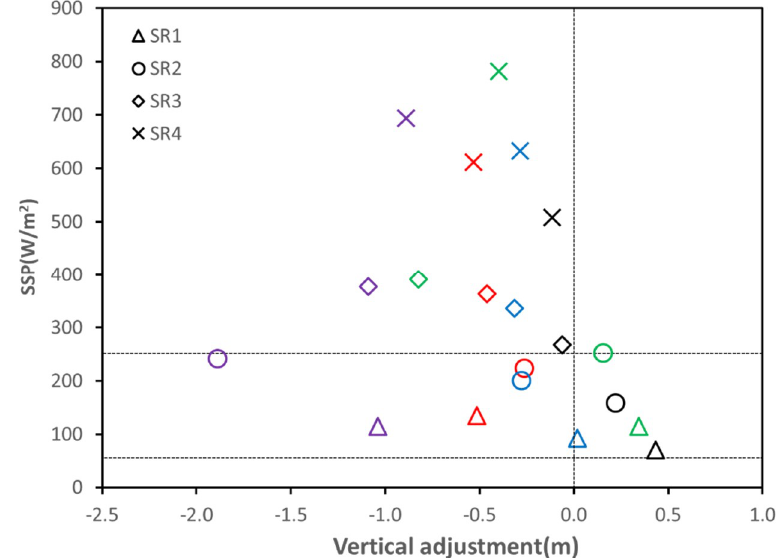
Figure 12. Relationship between specific stream power (SSP) and vertical adjustment. (Red means phase I; purple means phase II; green means phase III; blue means phase IV; black means phase V).